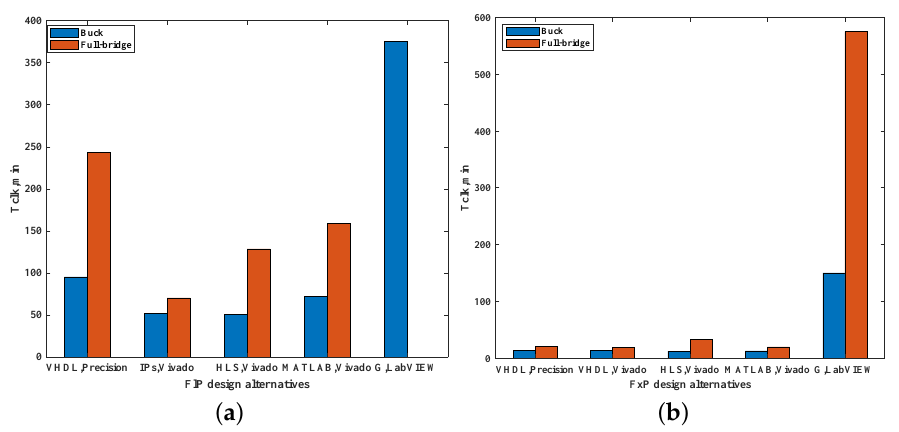
Figure 6. Minimum clock period for different design alternatives; ( a ) Floating-point design possibili- ties, ( b ) Fixed-point design